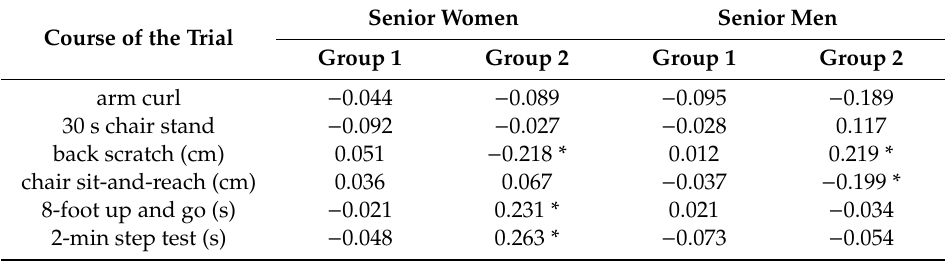
Table 8. Pearson correlation coe ffi cient for the functional fitness level and BMI of the seniors tested. Senior Women Senior Men Course of the Trial Group 1 Group 2 Group 1 Group 2 arm curl − 0.044 − 0.089 − 0.095 − 0.189 30 s chair stand − 0.092 − 0.027 − 0.028 0.117 back scratch (cm) 0.051 − 0.218 * 0.012 0.219 * chair sit-and-reach (cm) 0.036 0.067 − 0.037 − 0.199